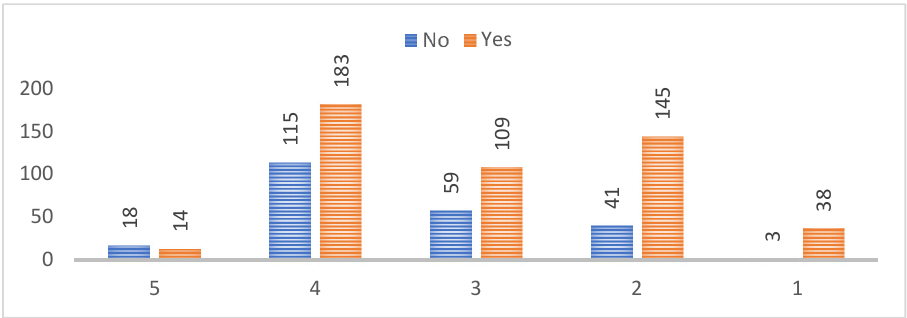
Figure 4. Distribution of respondents’ answers to the question about work experience (yes, no) and intention to start their own business (1, I have my own business; 2, yes, in the next three years; 3, yes, but first I will gain professional experience; 4, I do not reject this option; 5, no).